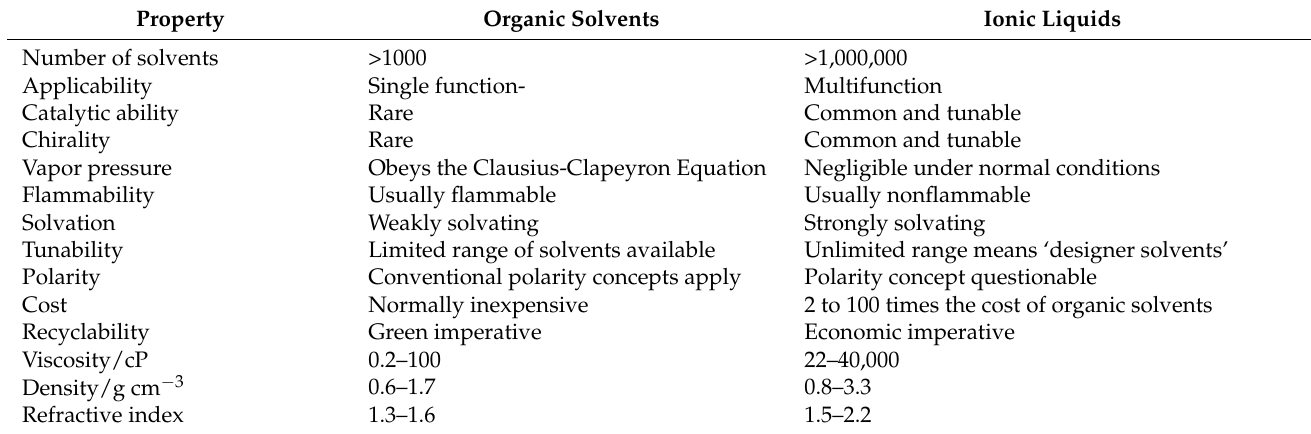
Table 1. A comparison of ionic liquids with organic solvents [9].